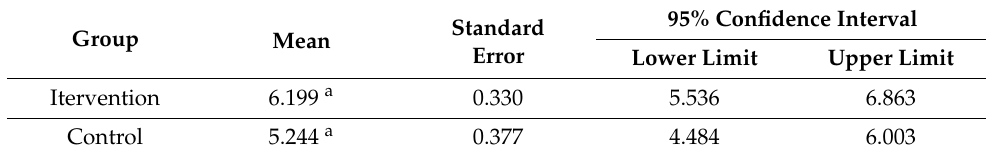
Table 3. Descriptive scores by learning group (marginal means).